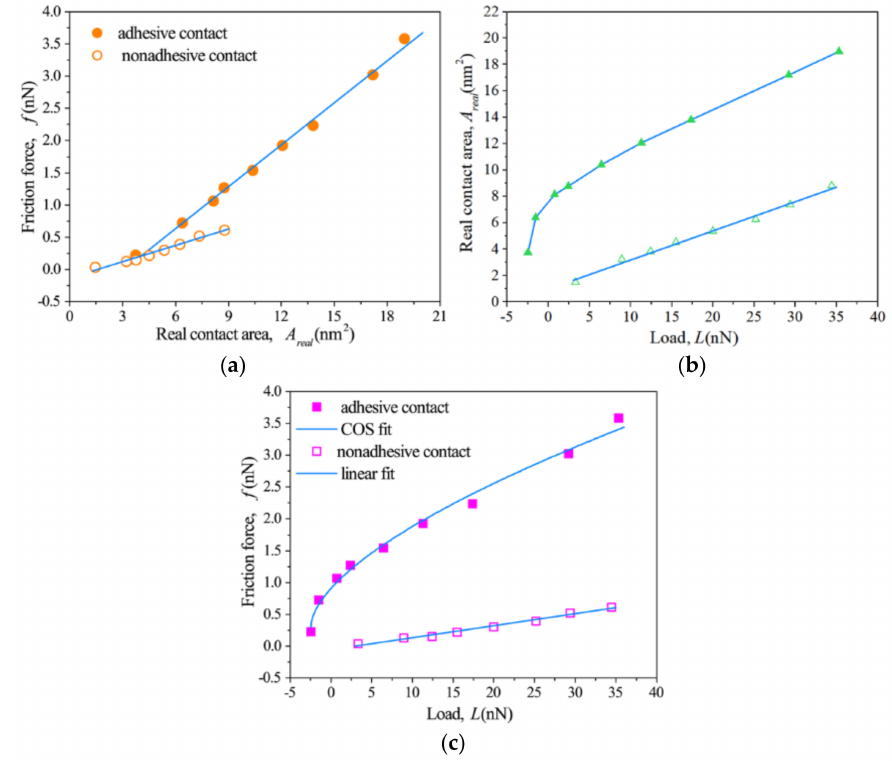
Figure 8. ( a ) Friction force versus real contact area, ( b ) real contact area versus normal load, ( c ) friction force versus normal load for flat